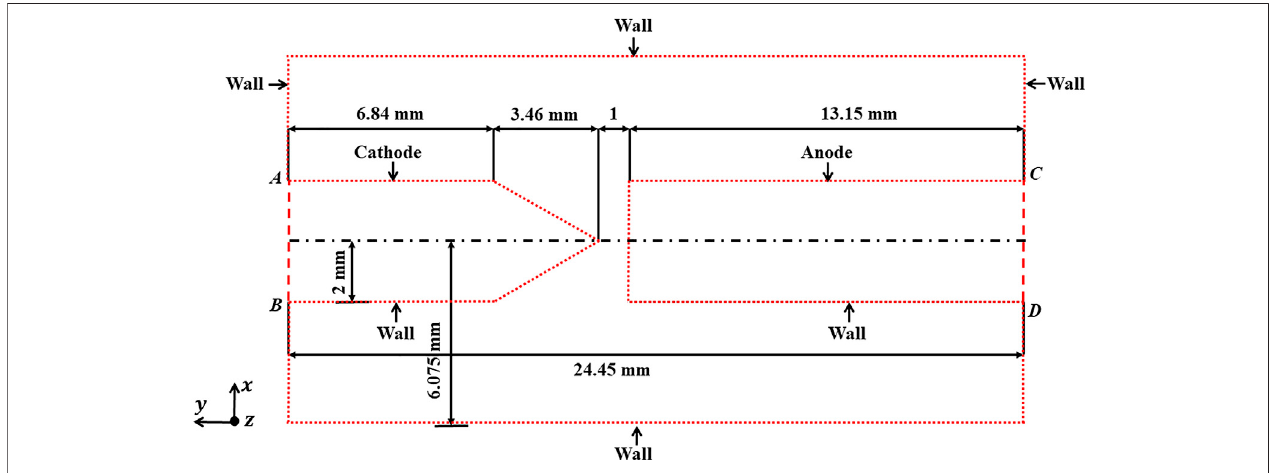
FIGURE 1 | A two-dimensional sketch of the computational